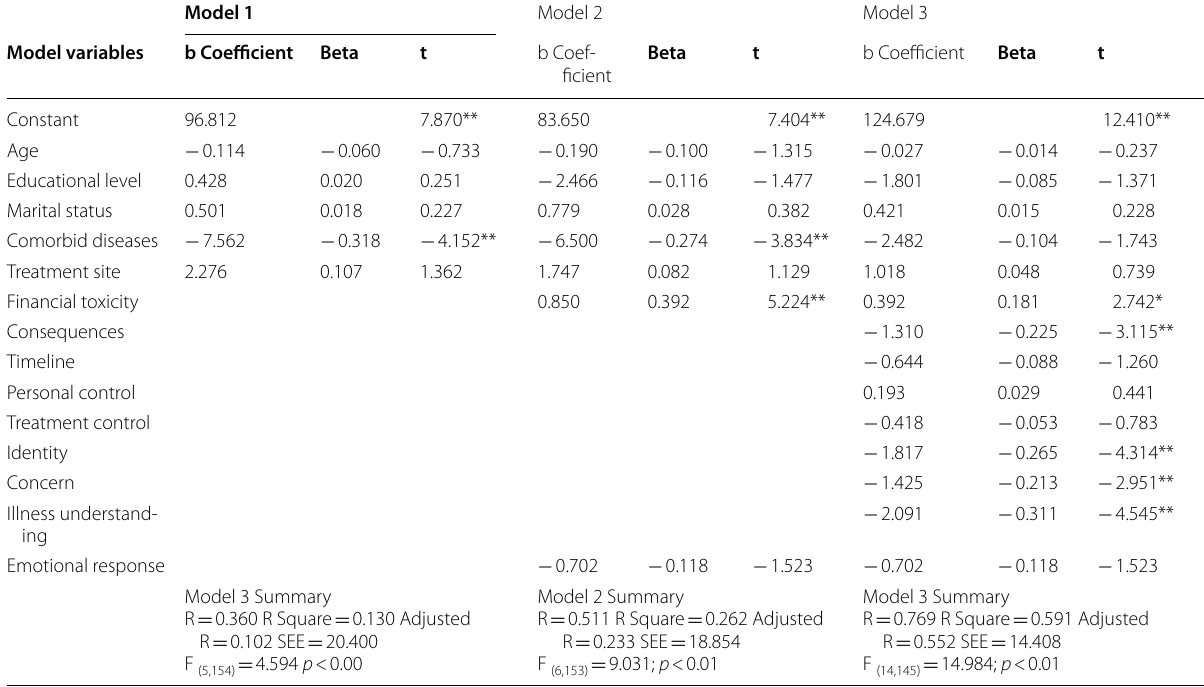
Table 3 Hierarchical regression analysis testing influence of demographic characteristics, financial toxicity and illness perception on QoL in prostate cancer